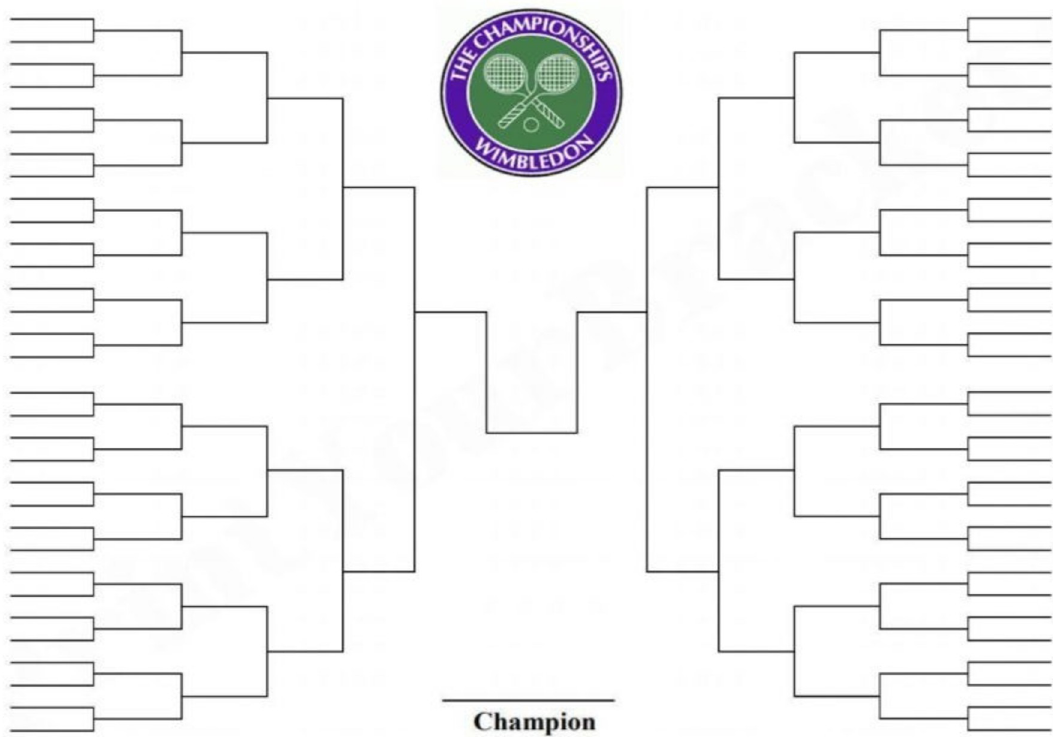
Fig 1. Wimbledon championship bracket. https://www.interbasket.net/wp-content/uploads/Wimbledon-bracket-1-of-2-print- 768x590.jpg.